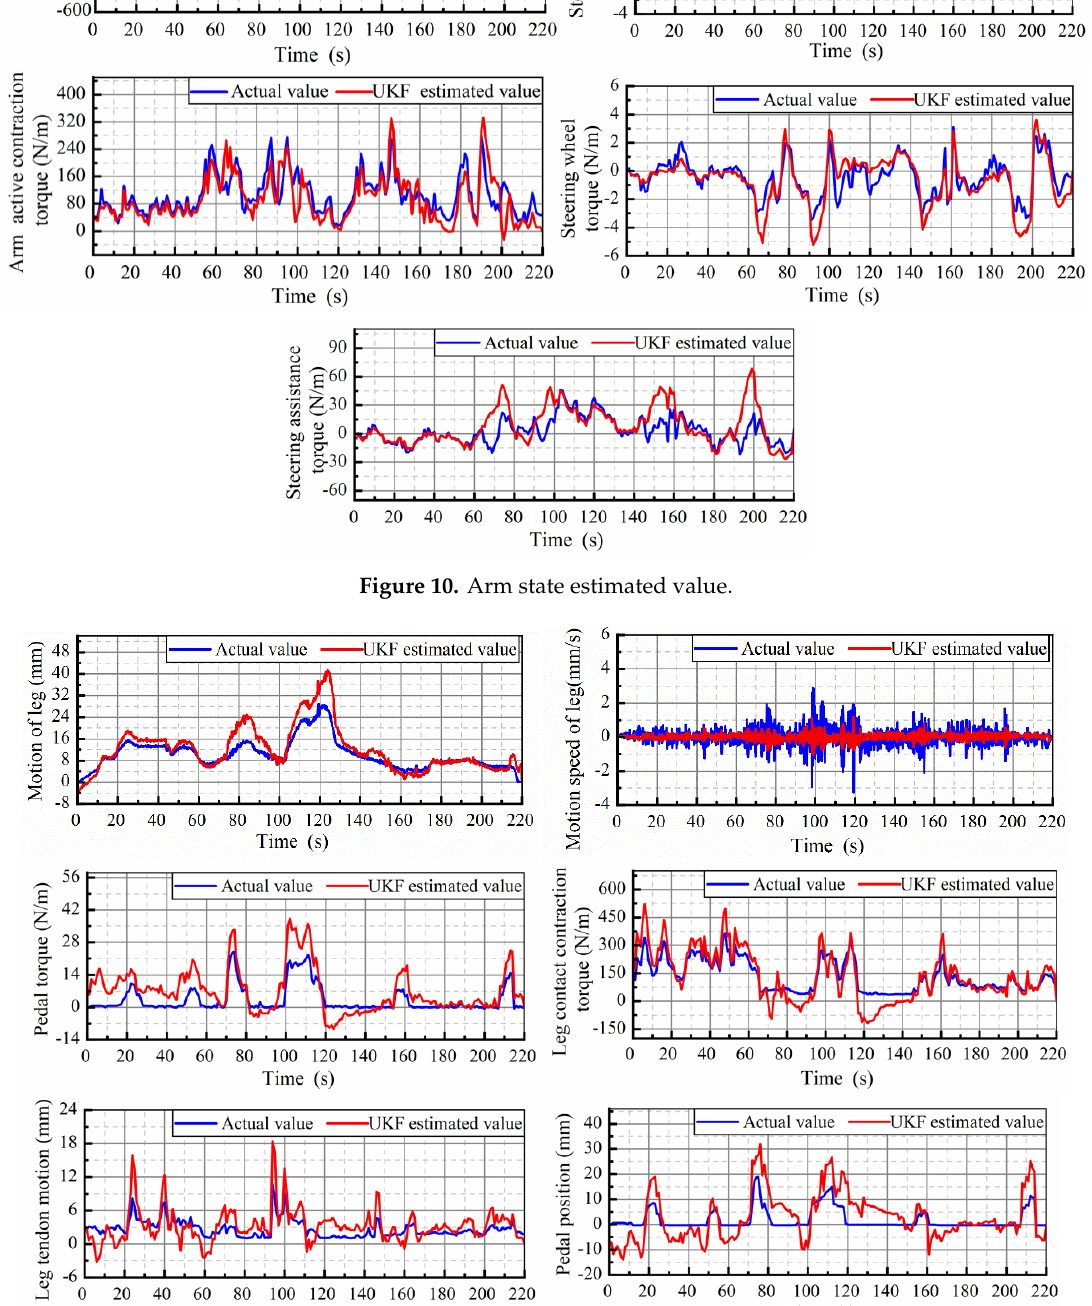
Figure 11. Leg state estimated value.